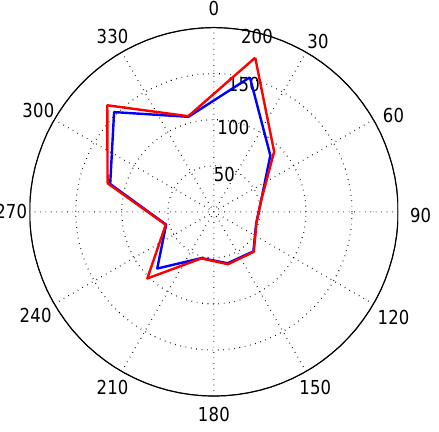
Fig. 10. Return level (cms − 1 ) for 50 (red) and 250 (blue) years return period at location FB, 499m